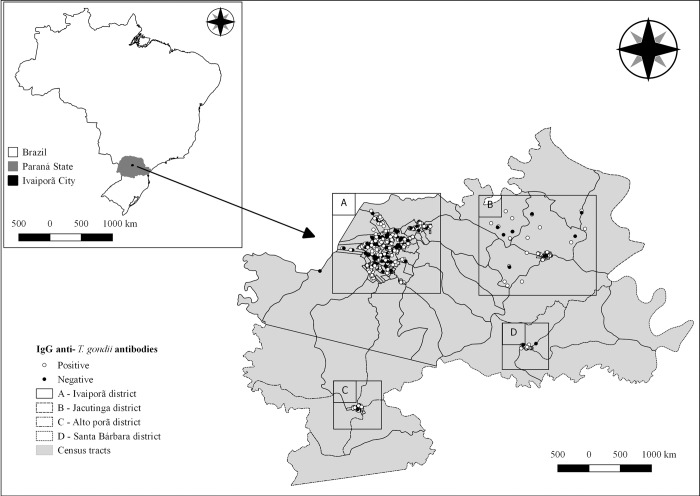
Location of Ivaiporã city, Paraná State, Brazil, including the serology results for IgG anti-T. gondii antibodies in 715 human samples tested by IFAT, from 2015 to 2016.